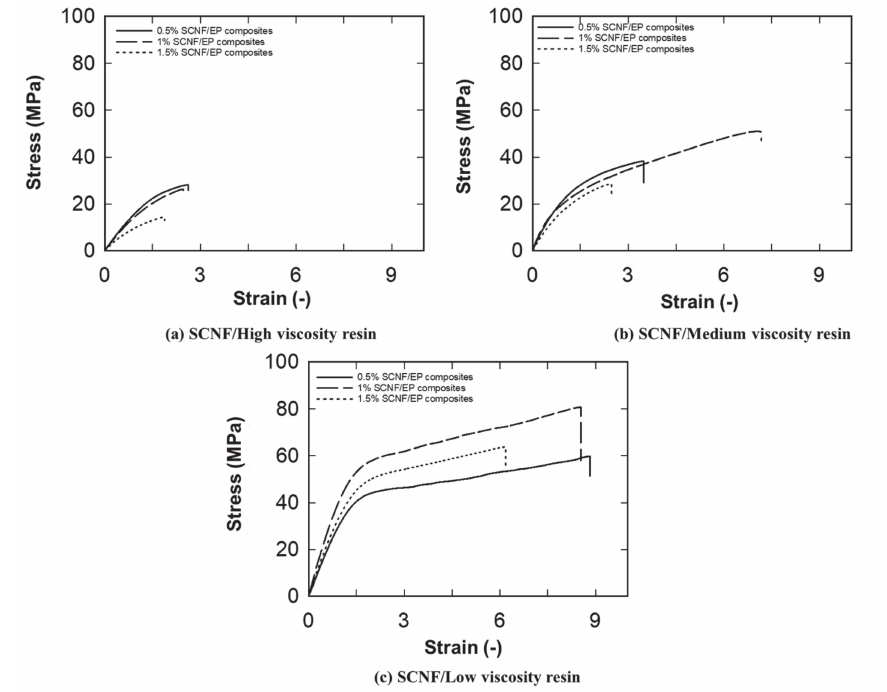
Figure 7. Typical stress − strain curves for ( a ) solvent treated CNF / high viscosity epoxy composites; ( b ) solvent treated CNF / medium viscosity epoxy composites; ( c ) solvent treated CNF / low viscosity epoxy composites.